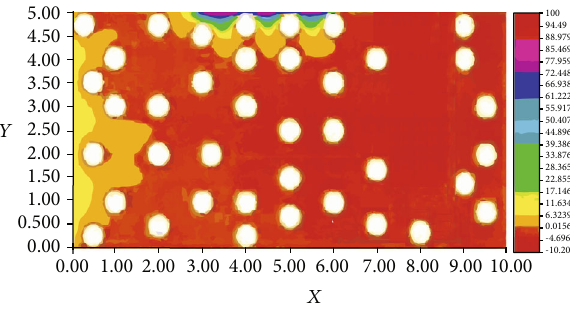
Figure 13: Concentration, D = 0 : 5 , C